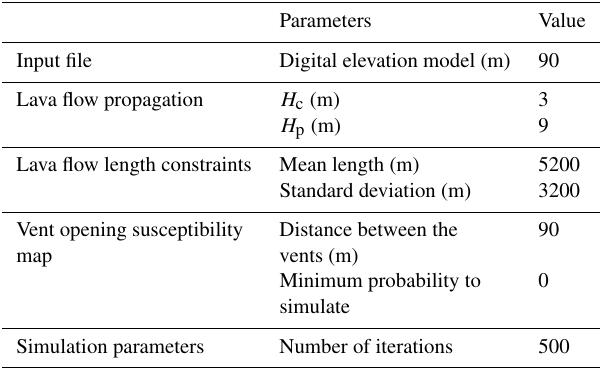
Table 1. Lava flow hazard map input parameters implemented in